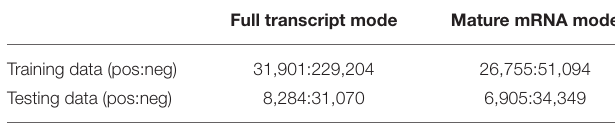
TABLE 2 | Numbers of samples in the training and testing datasets for m 6 A.